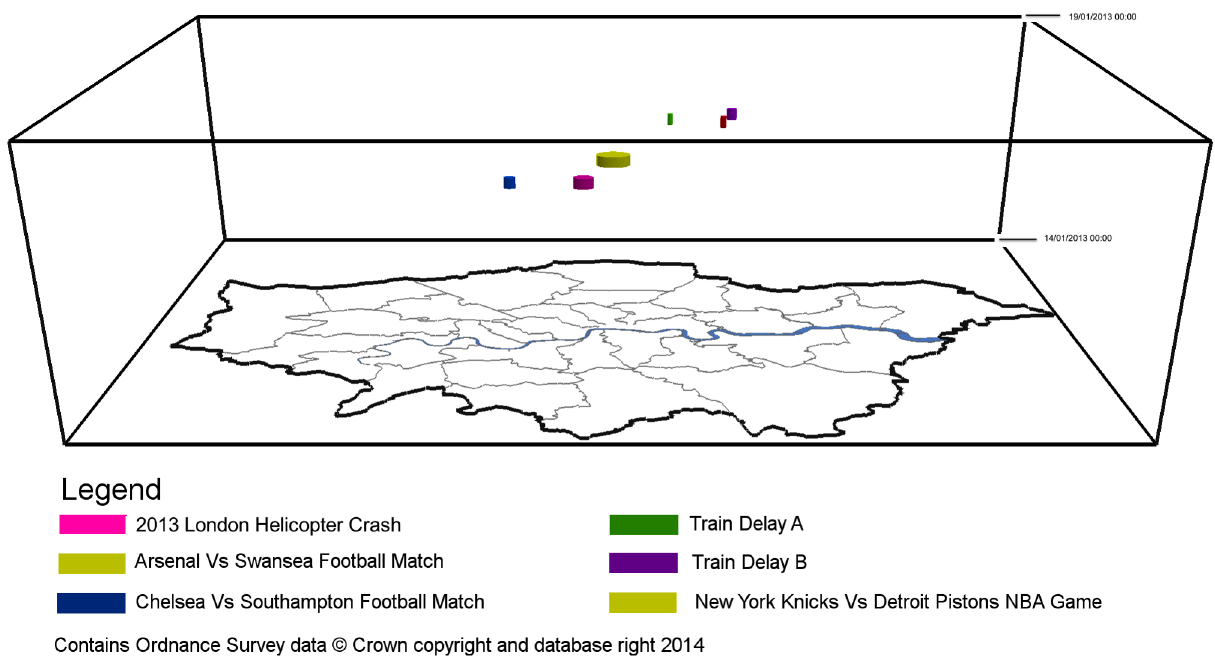
Figure 5. Daily cluster events identified within London between 14th January and 18th January 2013.